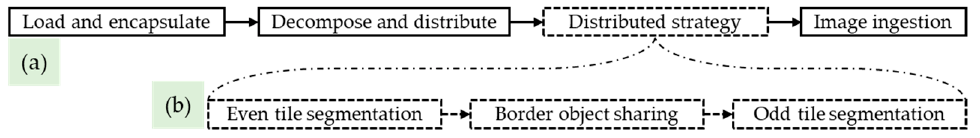
Figure 1. The data streams of the distributed image segmentation strategy based on Apache Spark. ( a ) The overall workflow; ( b ) The main procedures of the distributed strategy.